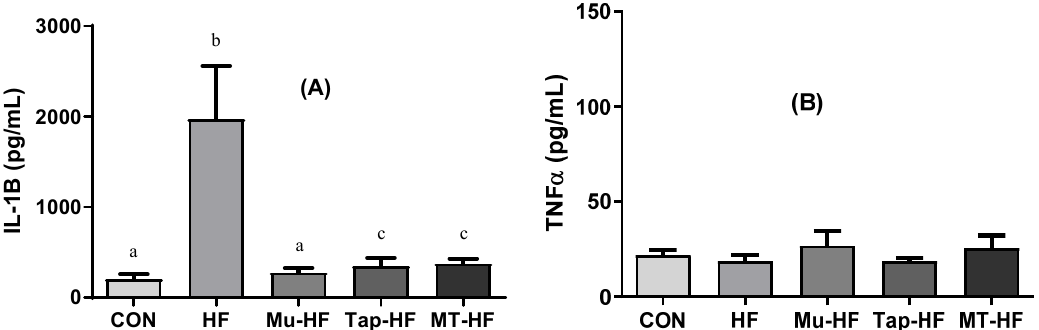
Figure 2. Inflammatory markers in plasma of rats with high-fat diet supplemented with murici and tapereba fruit-based beverages. ( A ) Interleukin-1 beta (IL-1 β ). ( B ) Tumor necrosis factor- α (TNF- α ). CON = control group; HF = high-fat group; Mu-HF = murici beverage group; Tap-HF = tapereba beverage group; MT-HF = murici and tapereba blend group. All values are expressed as mean ± SD. n = 4 to 10 per group. Means with different letters are significantly different ( p < 0.05, Tukey’s